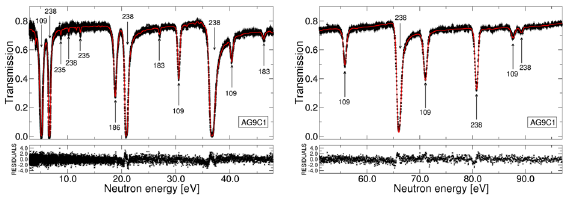
Figure 5. Transmission spectra through the AG9C1 are com- pared with the theoretical REFIT calculation using Eq.